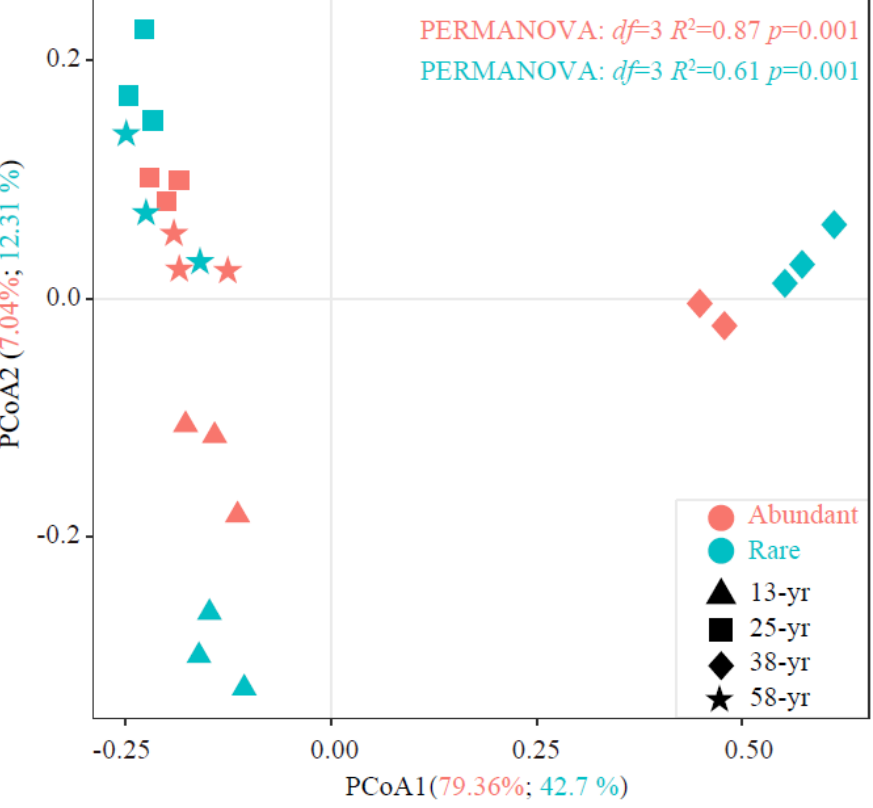
Figure 2. Principal coordinate analysis (PCoA) showing the composition of bacterial communities of abundant and rare taxa across P. massoniana stands of different ages.